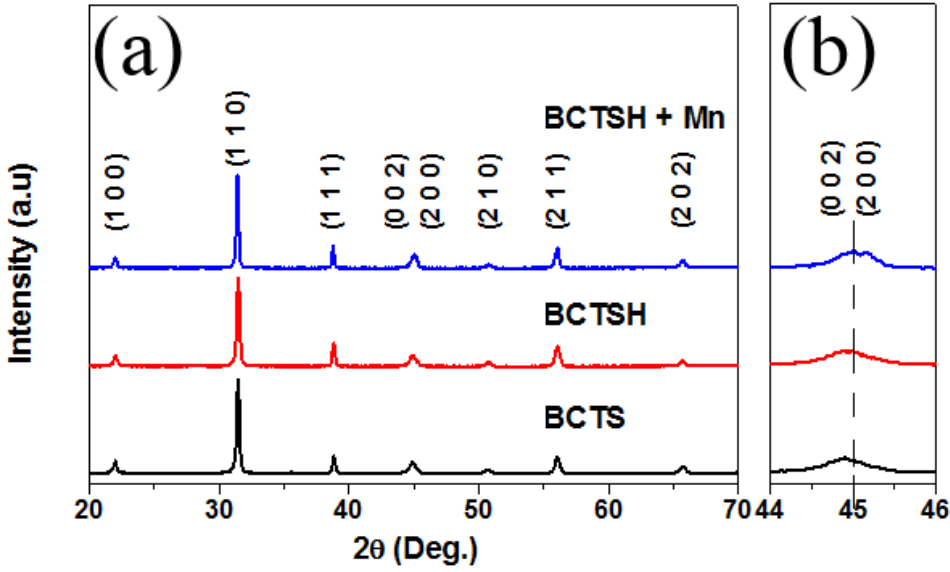
Figure 2. ( a ) XRD patterns and ( b ) Enlarged patterns in the range of 44–46 degrees for BCTS, BCTSH and Mn-doped BCTSH ceramics.